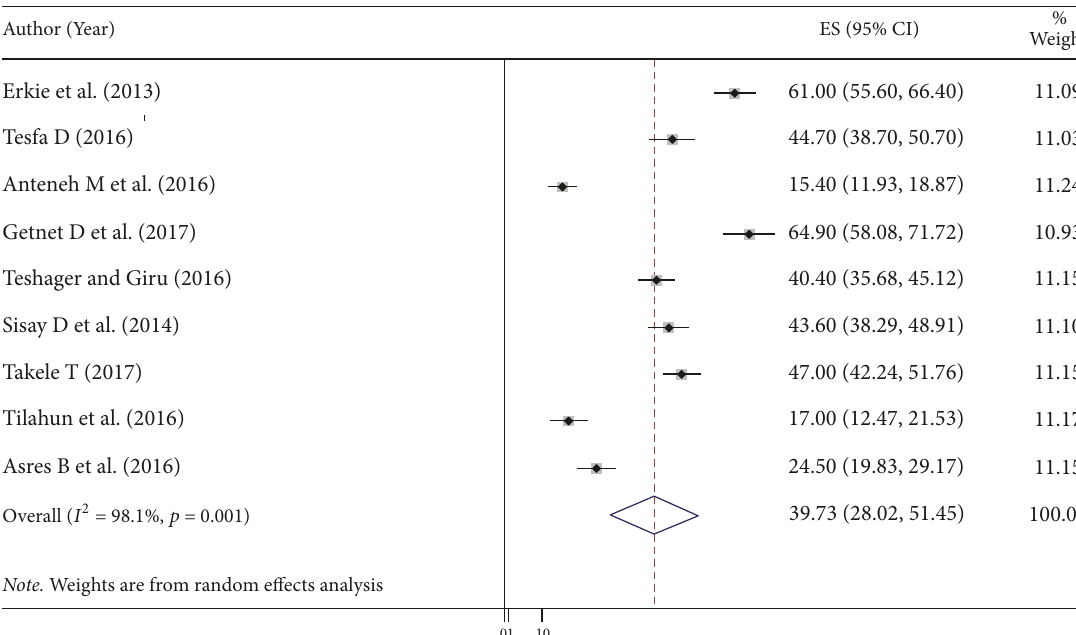
Figure 2: Forest plot showing the pooled prevalence of depression among diabetic patients in Ethiopia, 2018.